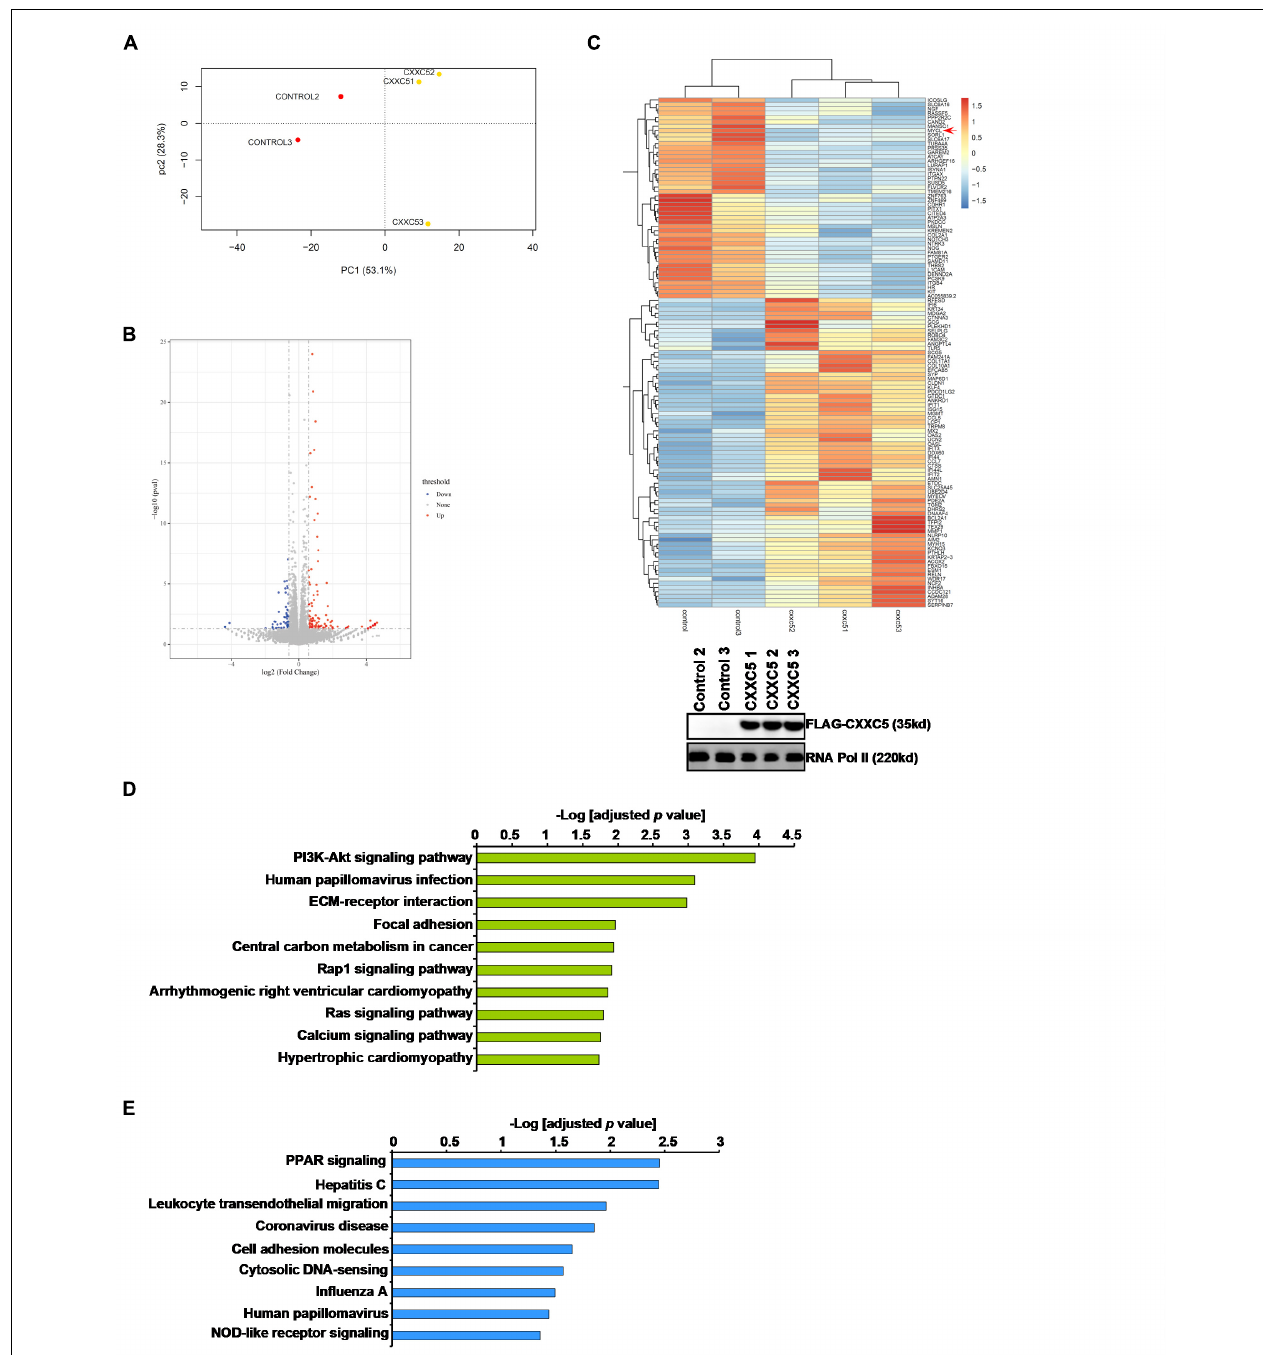
FIGURE 3 | CXXC5 over-expression alters HSC transcriptome. LX-2 cells were infected with adenovirus carrying CXXC5 expression vector (Ad-CXXC5) or GFP (Ad-GFP). RNA-seq was performed as described in section “Materials and Methods.” (A) Sample clustering. (B) Volcano plot. (C) Heat map. Inset, CXXC5 over-expression levels were examined by Western blotting. (D) GO analysis. (E) KEGG